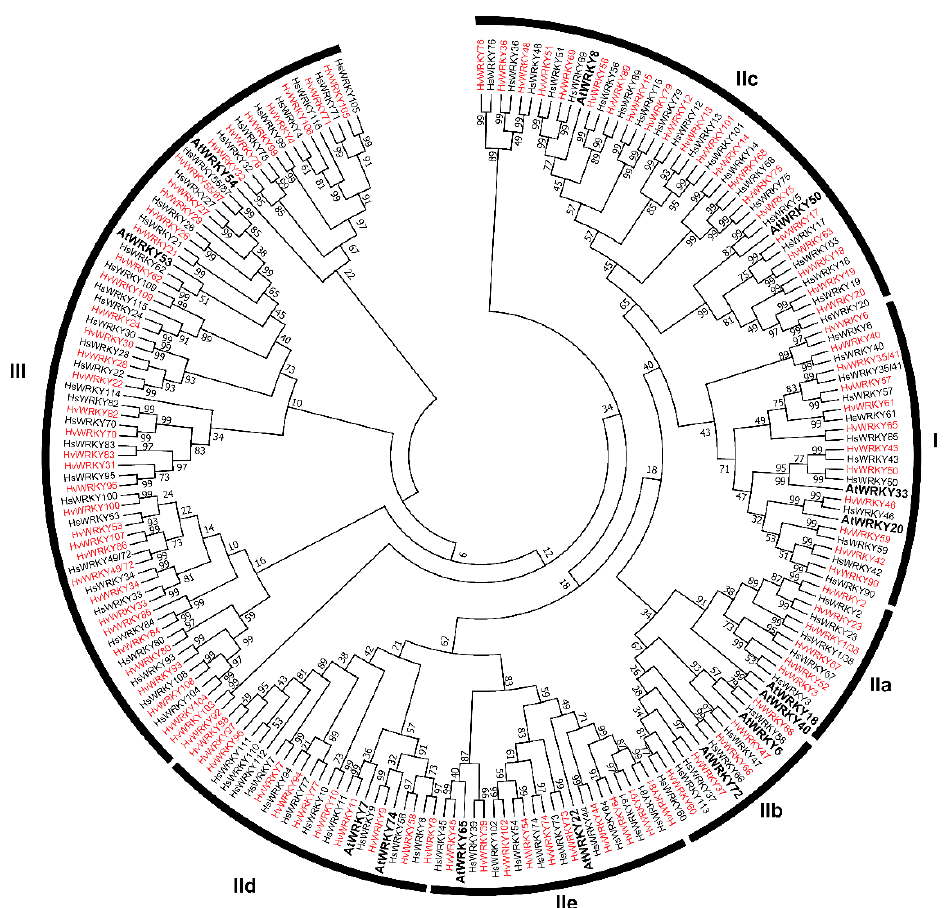
Figure 1. The phylogenetic tree of barley WRKYs . The WRKYs derived from wild and cultivated barley are highlighted with black and red font respectively, while A. thaliana WRKYs is represented with bold black. The values of the nodes are the bootstraps. The groups and sub-groups are indicated (I, II a–e and III).